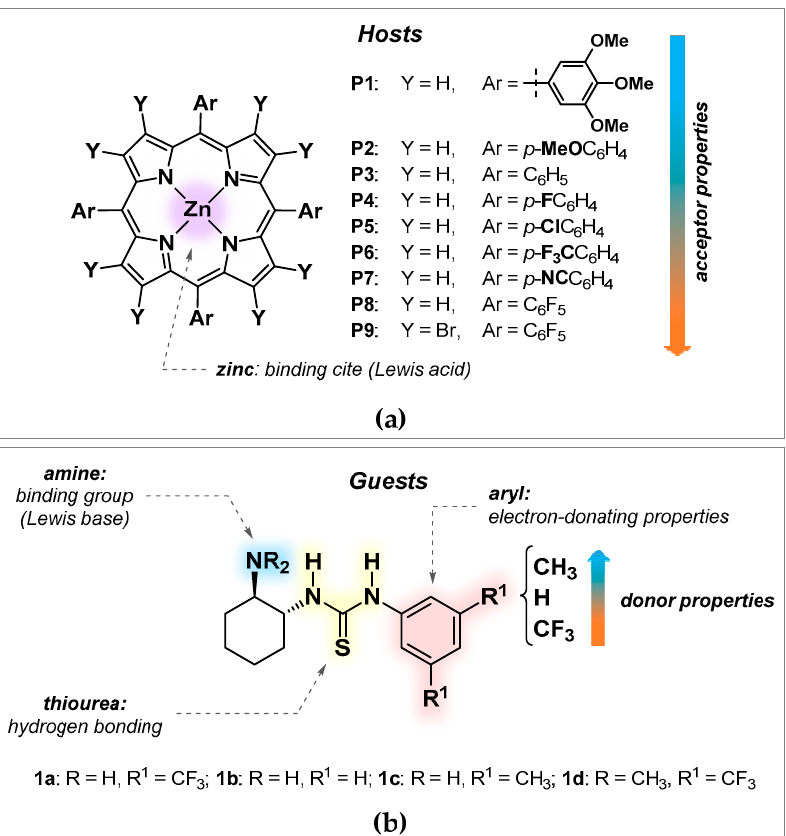
Figure 1. ( a ) Structures of zinc porphyrins P1 – P9 used as hosts and detector entities for plausible chemosensors; ( b ) Scope of chiral 2-aminocyclohexyl arylthioureas 1a – d (depicted as R , R -enantiomers), studied in this work as guest molecules and model pollutants with highlighting the diversity of binding sites.